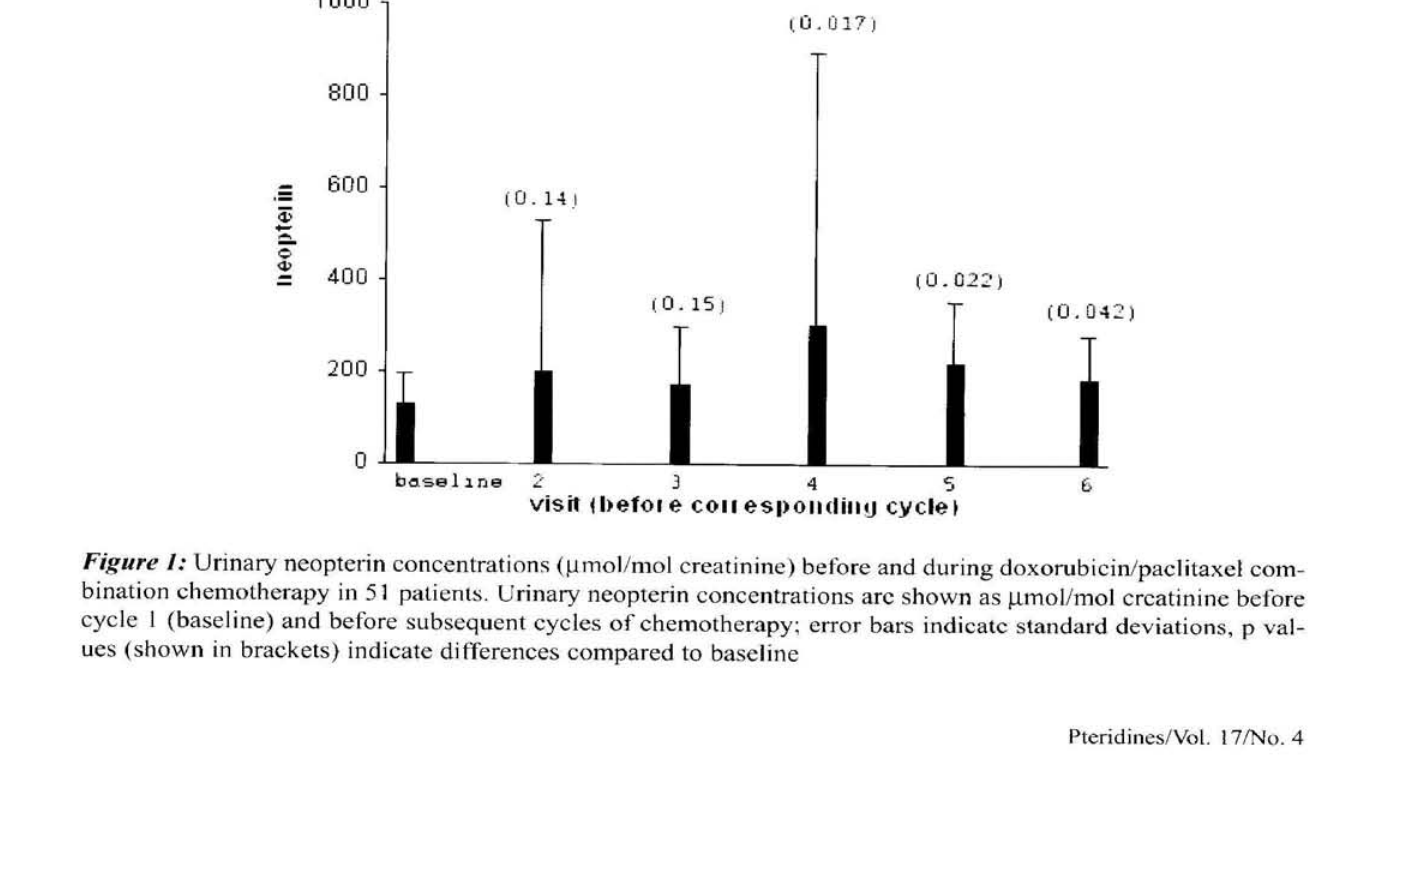
Pteridines/Vol. 17/No.